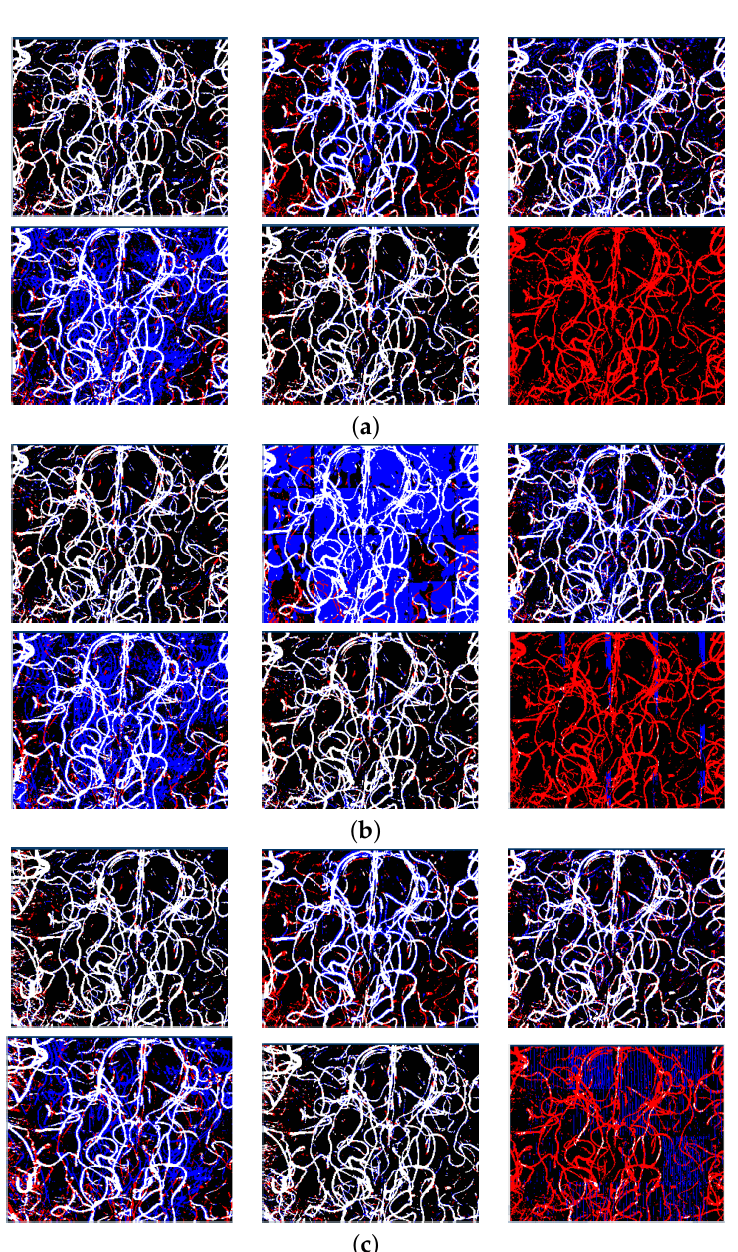
Figure A2. Performance of the models without deformation-aware learning, while dealing with various MR artefacts: (First row left to right) Random Bias Field, Random Blur, Elastic deformation (Second row left to right) Random Motion, Random Noise, and Random Spike. Red indicates false negative and blue indicates false positive while comparing against the dataset labels. ( a ) U-Net. ( b ) Attention U-Net. ( c ) U-Net